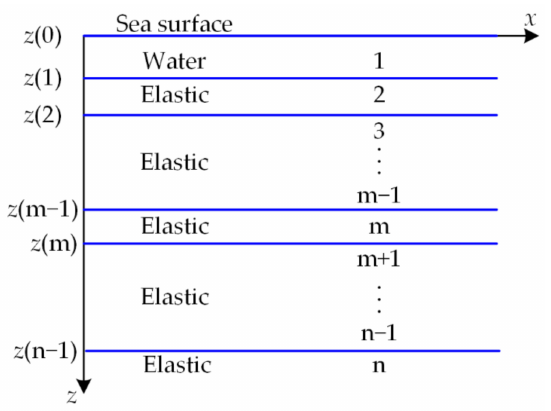
Figure 2. Layered ocean structure with horizontal